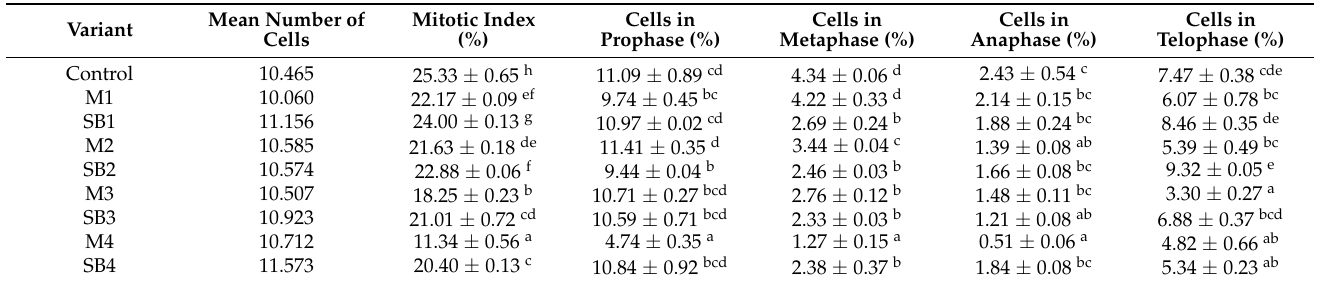
Table 1. Mitotic phases of wheat root meristem cells exposed to different concentrations of Merlot and Sauvignon blanc grape marc extracts.